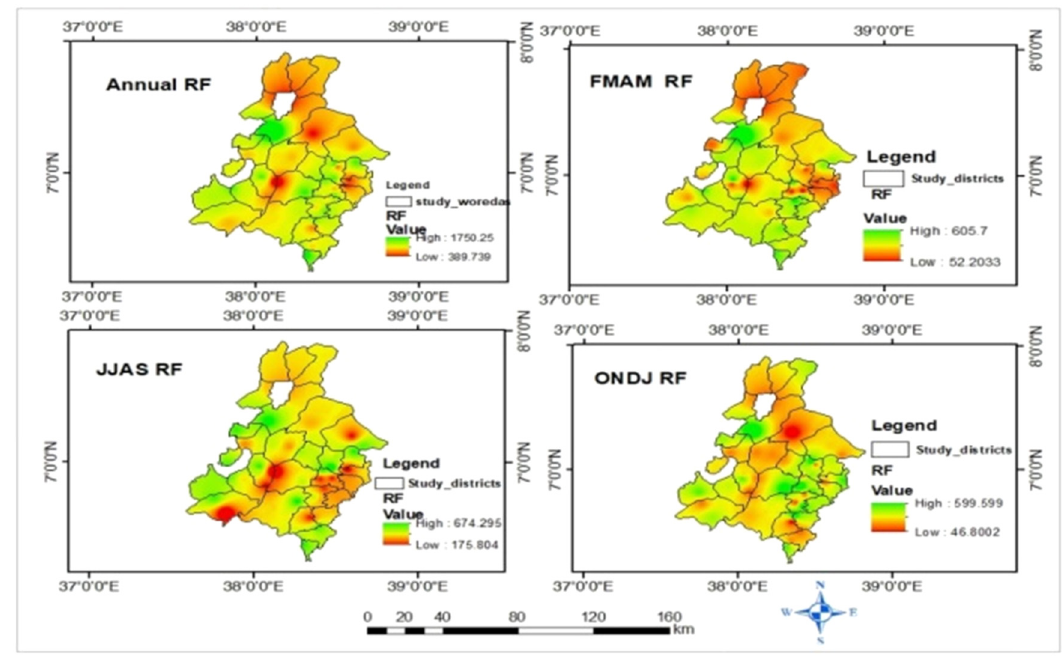
Figure 2: Rainfall distribution in annual, ONDJ, FMAM, and JJAS seasons in the study area.